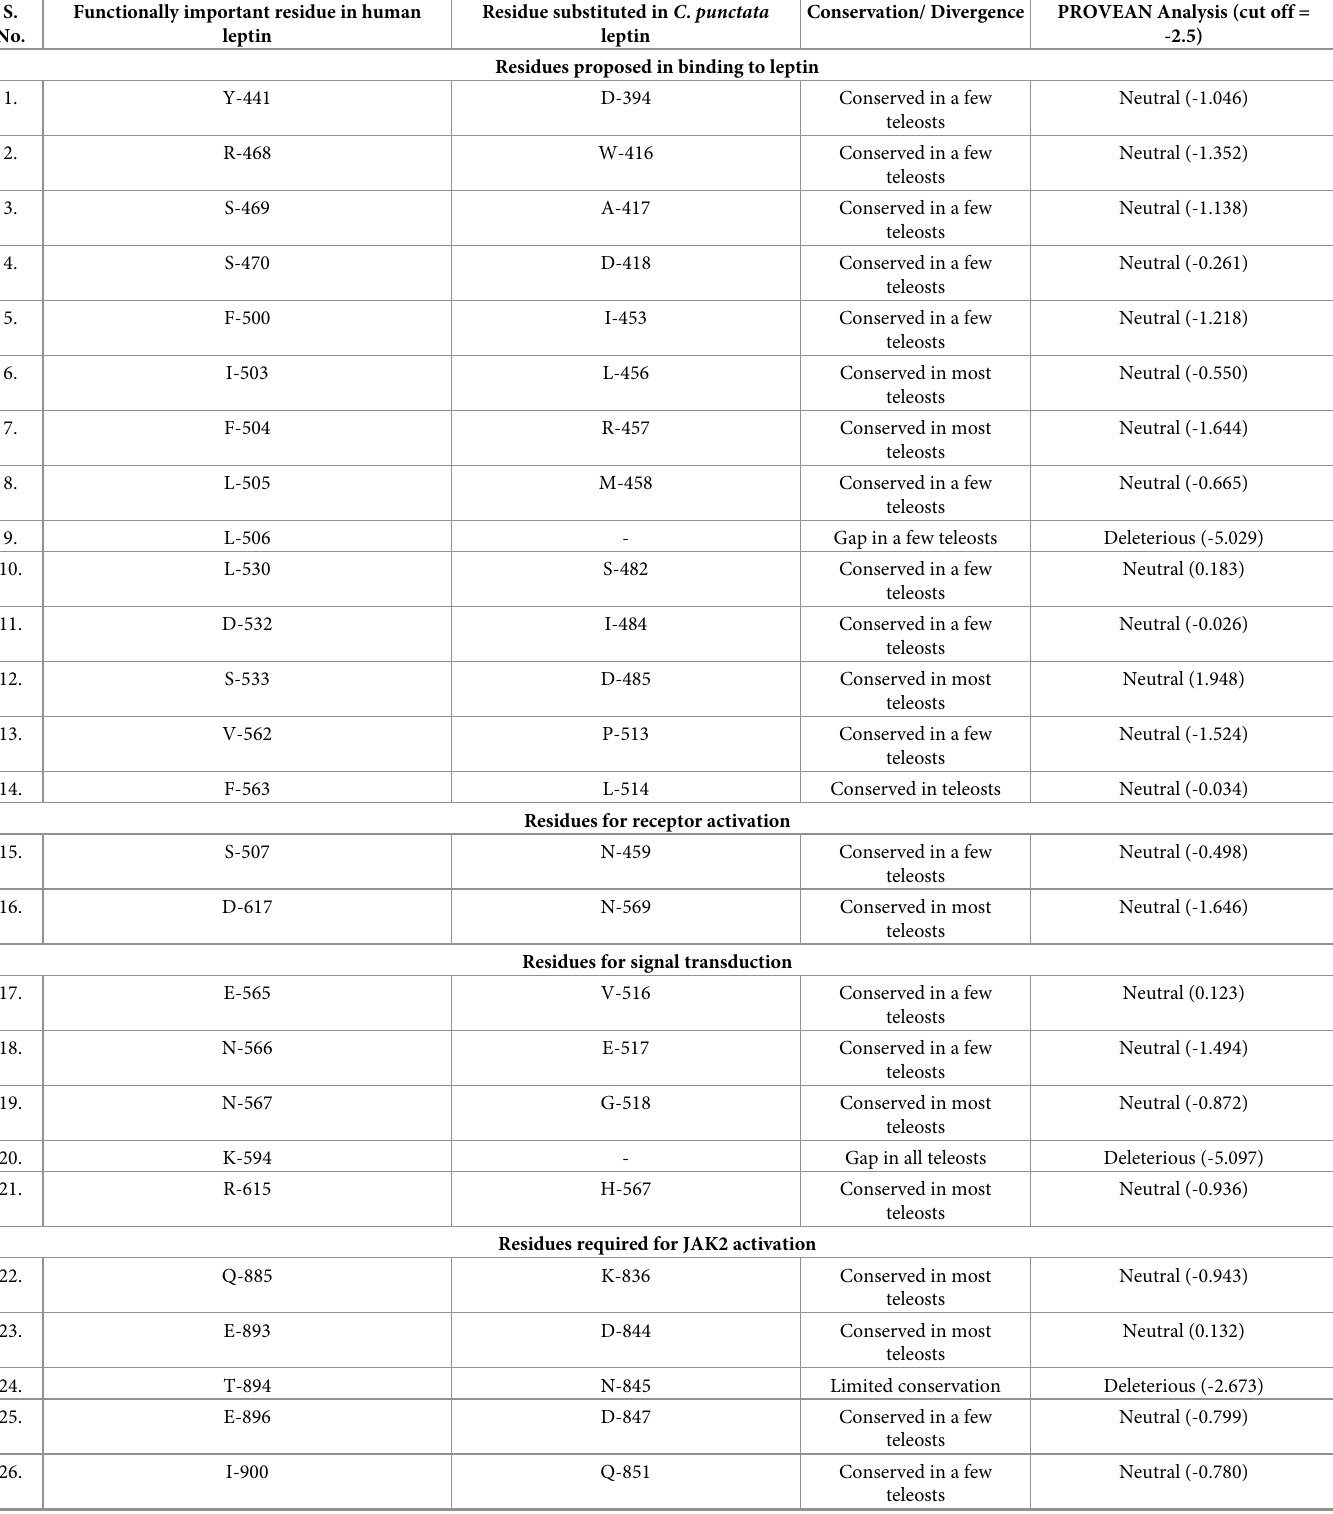
Table 3. Possible effect of substitution/deletion at functionally significant sites of leptin receptor of Channa punctata . S.